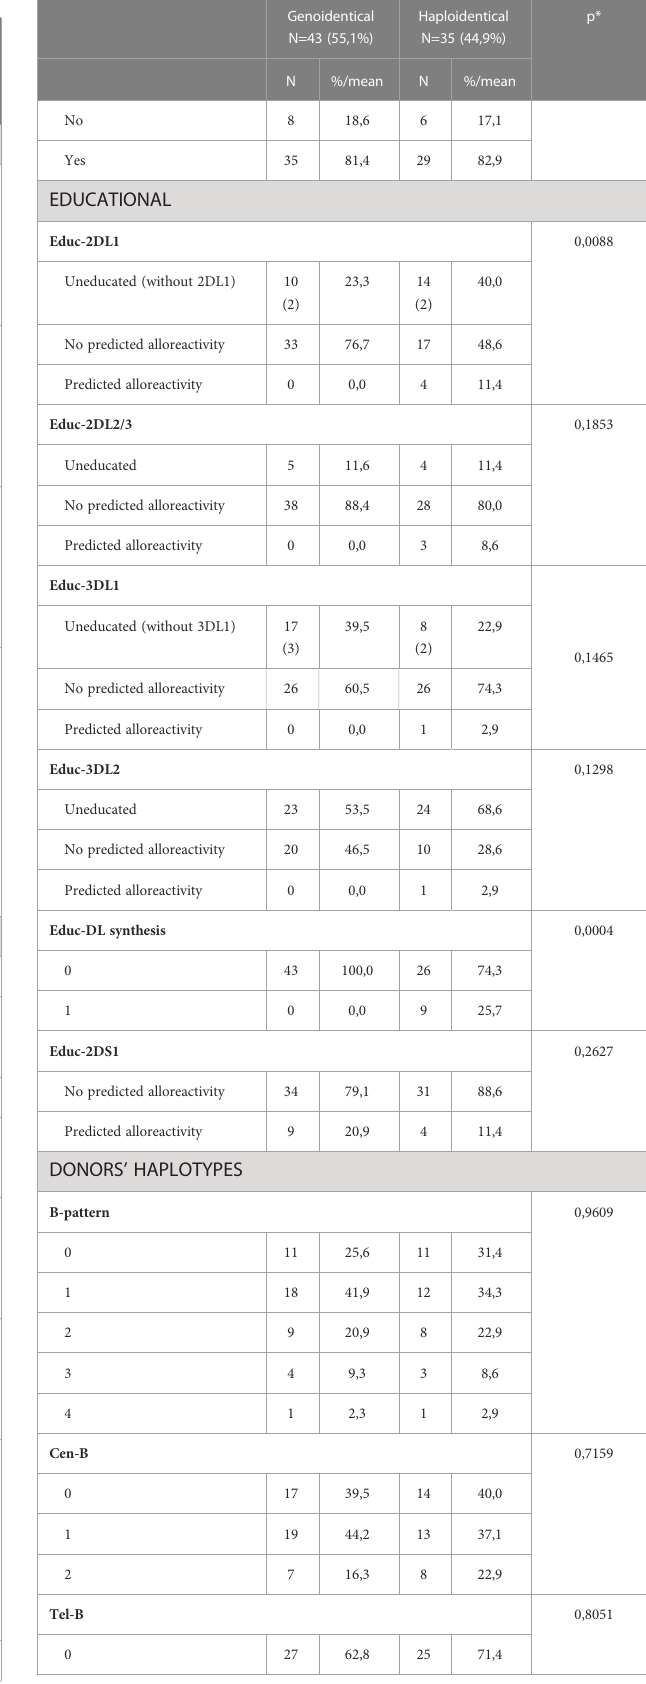
TABLE 1 Distribution of pairs predicted to be alloreactive according each model.